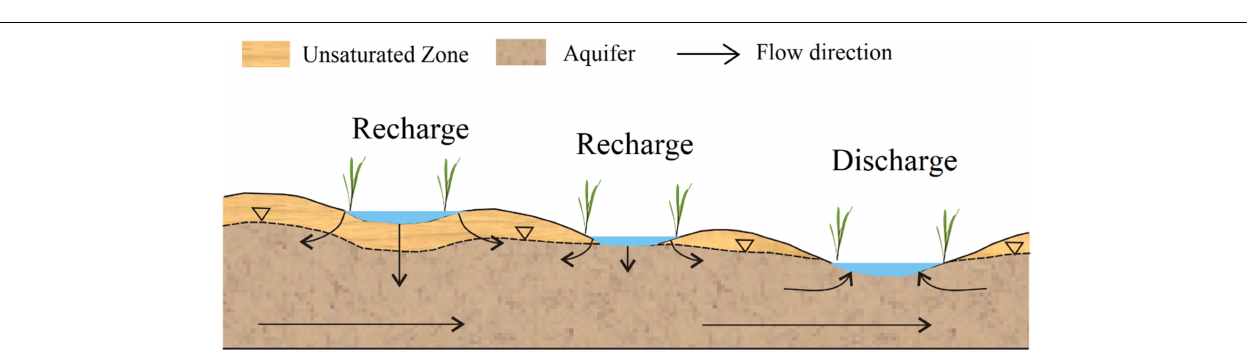
Frontiers in Ecology and Evolution |